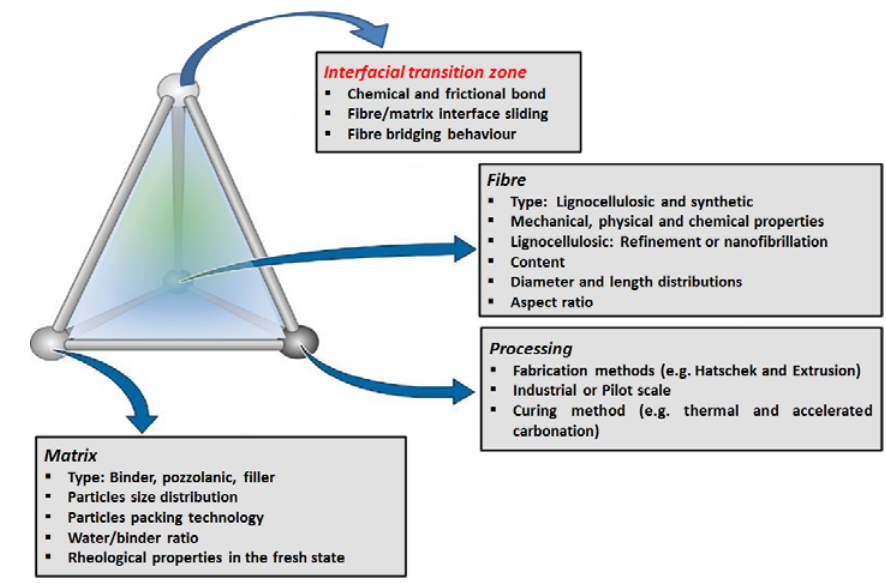
Figure 4. The tetrahedral interrelation of the main constituents of the cement based composite design. Adapted from [8].